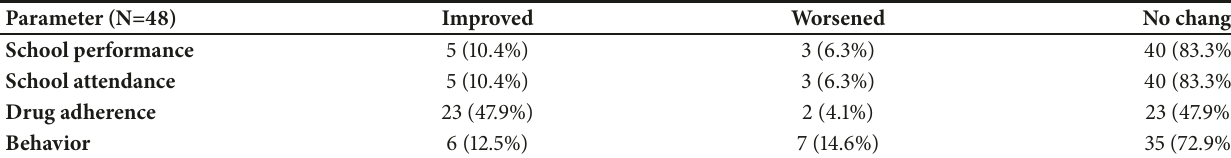
Table 5: Impact of disclosure on